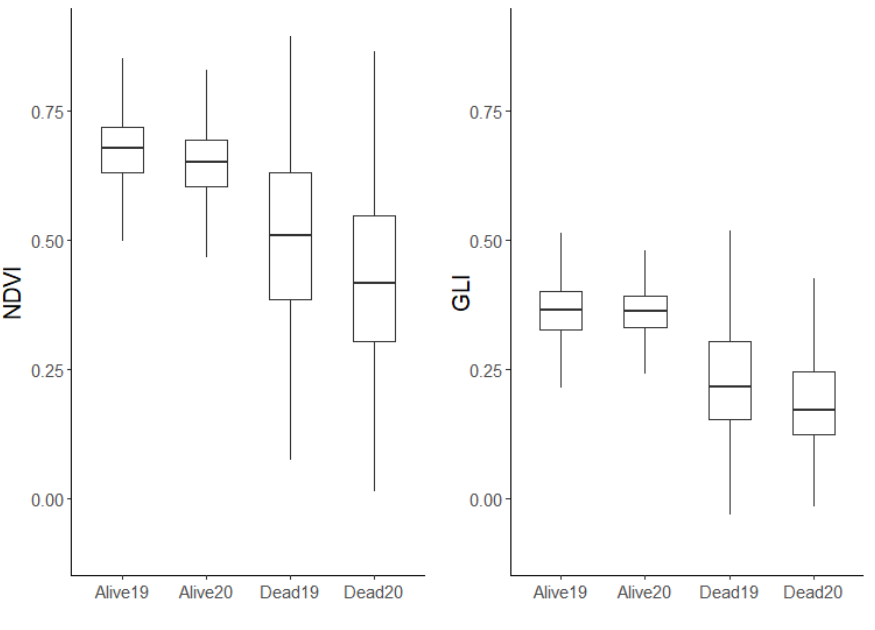
Figure 6. Distribution of NDVI and GLI for trees that survived and died, by year. Alive or dead refers to the trees’ health in 2020. Trees that were already dead in 2019 were